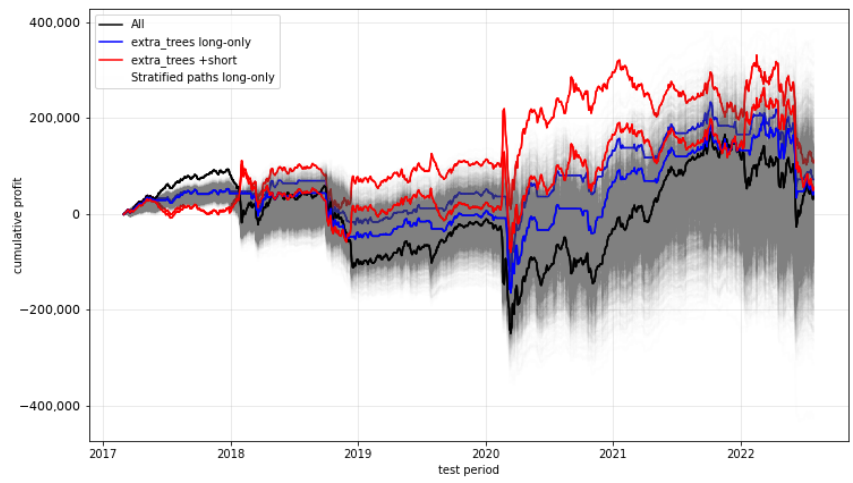
Figure 8. Cumulative profit of the extra trees predictions.